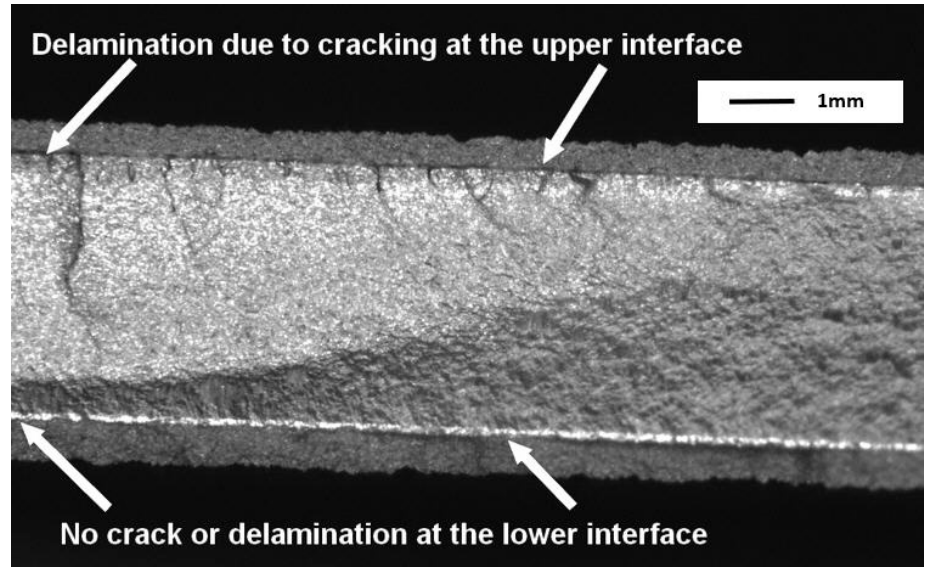
Figure 8. Note the delamination is associated with crack growth and the intact nature of the interface on the opposing (uncracked) surface.